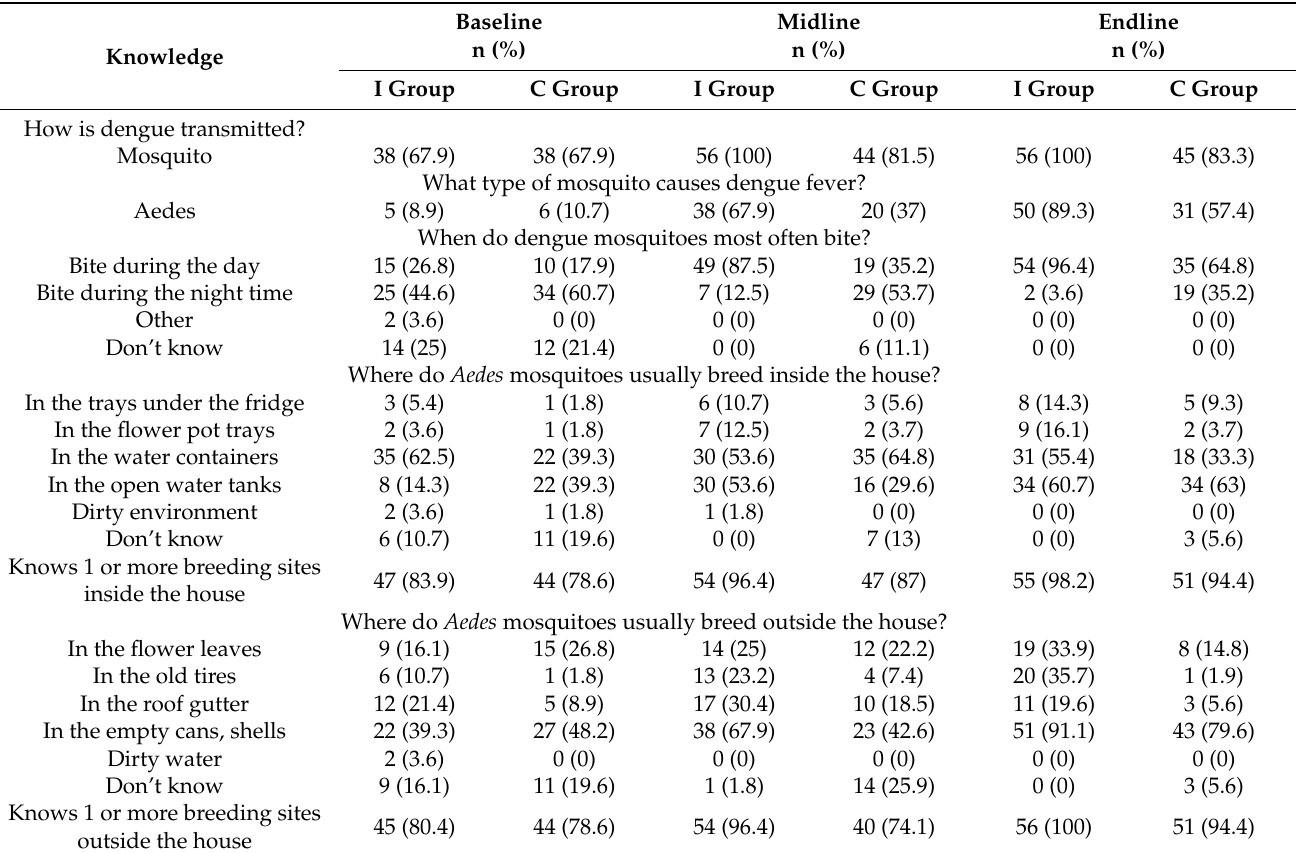
Table 4. Knowledge about dengue transmission, prevention practice, and symptoms at the baseline, midline, and endline. ‘I’ means intervention group and ‘C’ means control